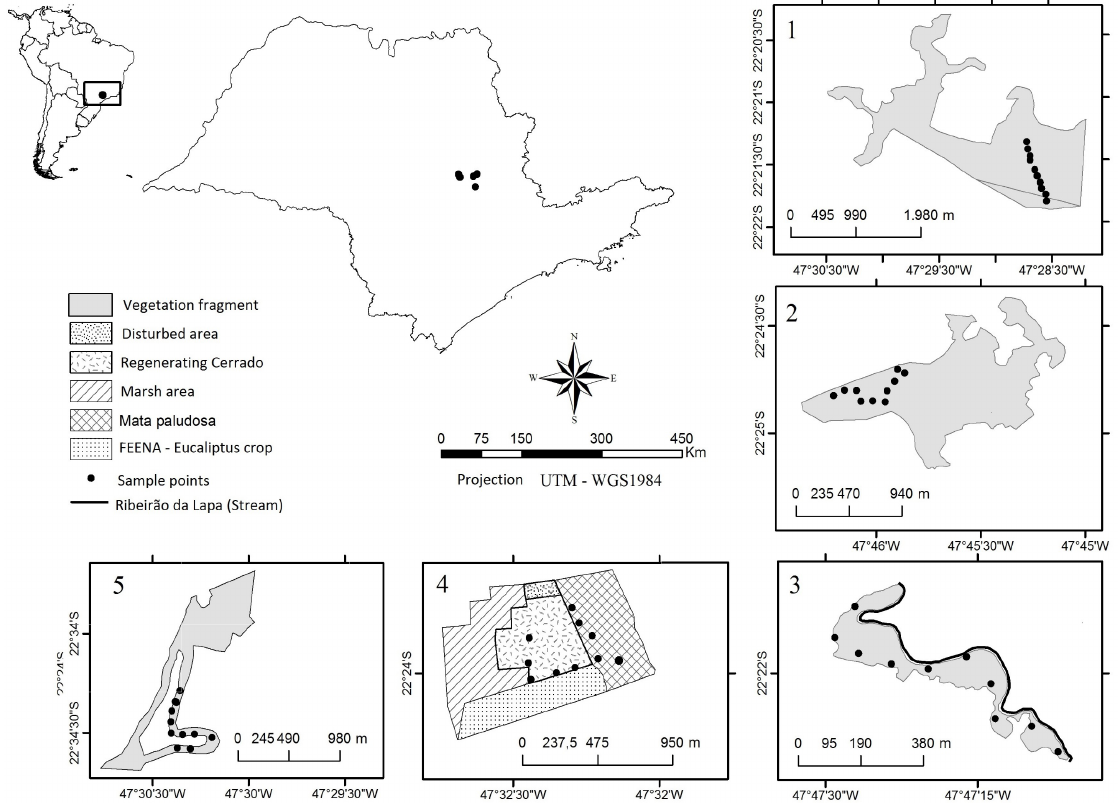
Fig 1 . Map showing the distribution of the sampling sites and sampling points within each site. 1: Semideciduous forest; 2: Cerradão; 3. Riparian forest; 4. Regenerating Cerrado; and 5. Restored